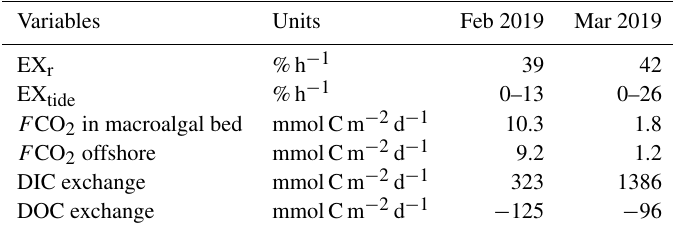
Table 3. Water exchange rates (EX r and EX tide ), F CO 2 , DIC exchange, and DOC exchange, which were estimated by using mass-balance models. Carbon fluxes were calculated as millimoles per square meter of the surface area of the algal bed per